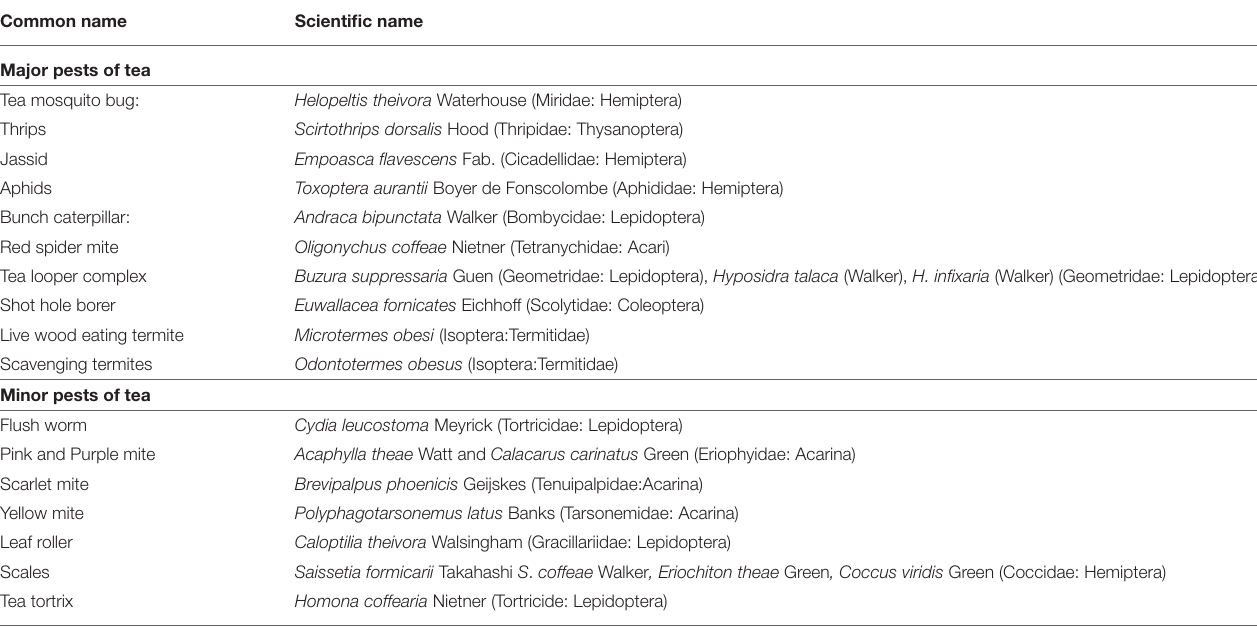
TABLE 1 | Different pests of tea crop [source: Deka et al. (6, 7); Babu (8); Hazarika et al.